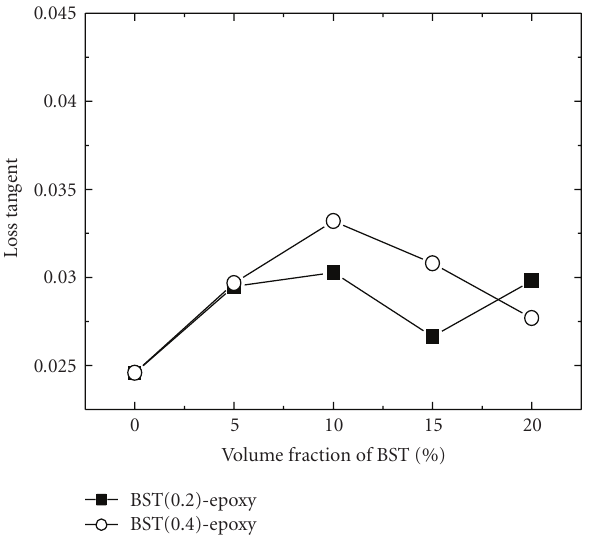
Figure 5: Loss tangent of BST-epoxy composites at 10 KHz as function of volume fraction.